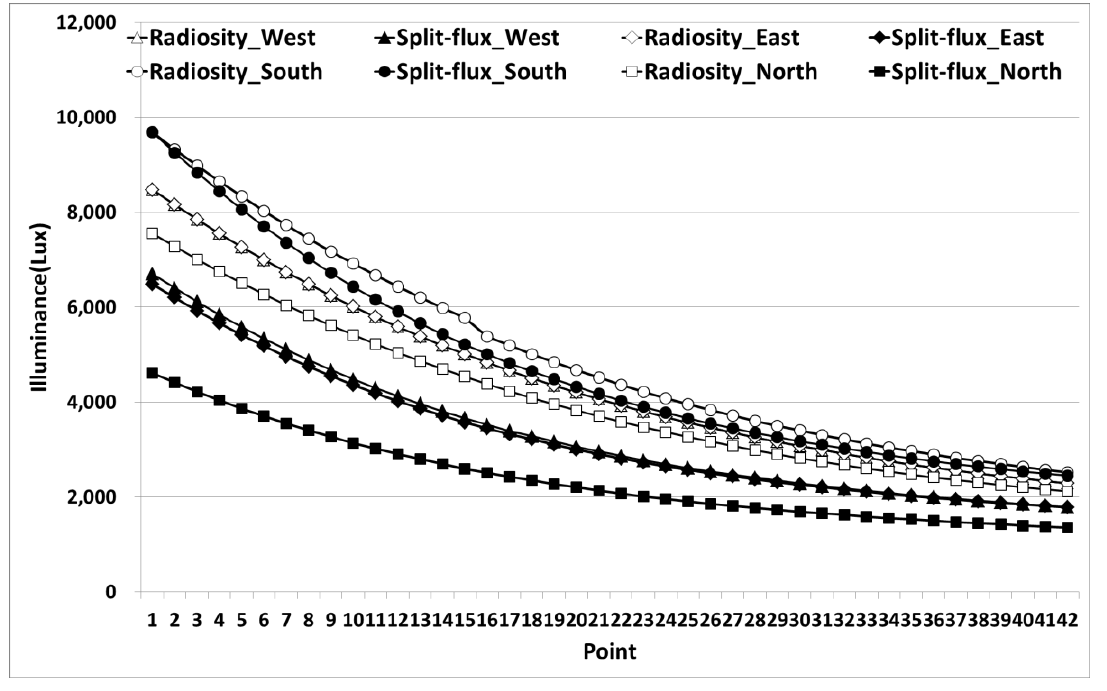
Figure 1. Interior illuminance at 42 reference points for four orientations of